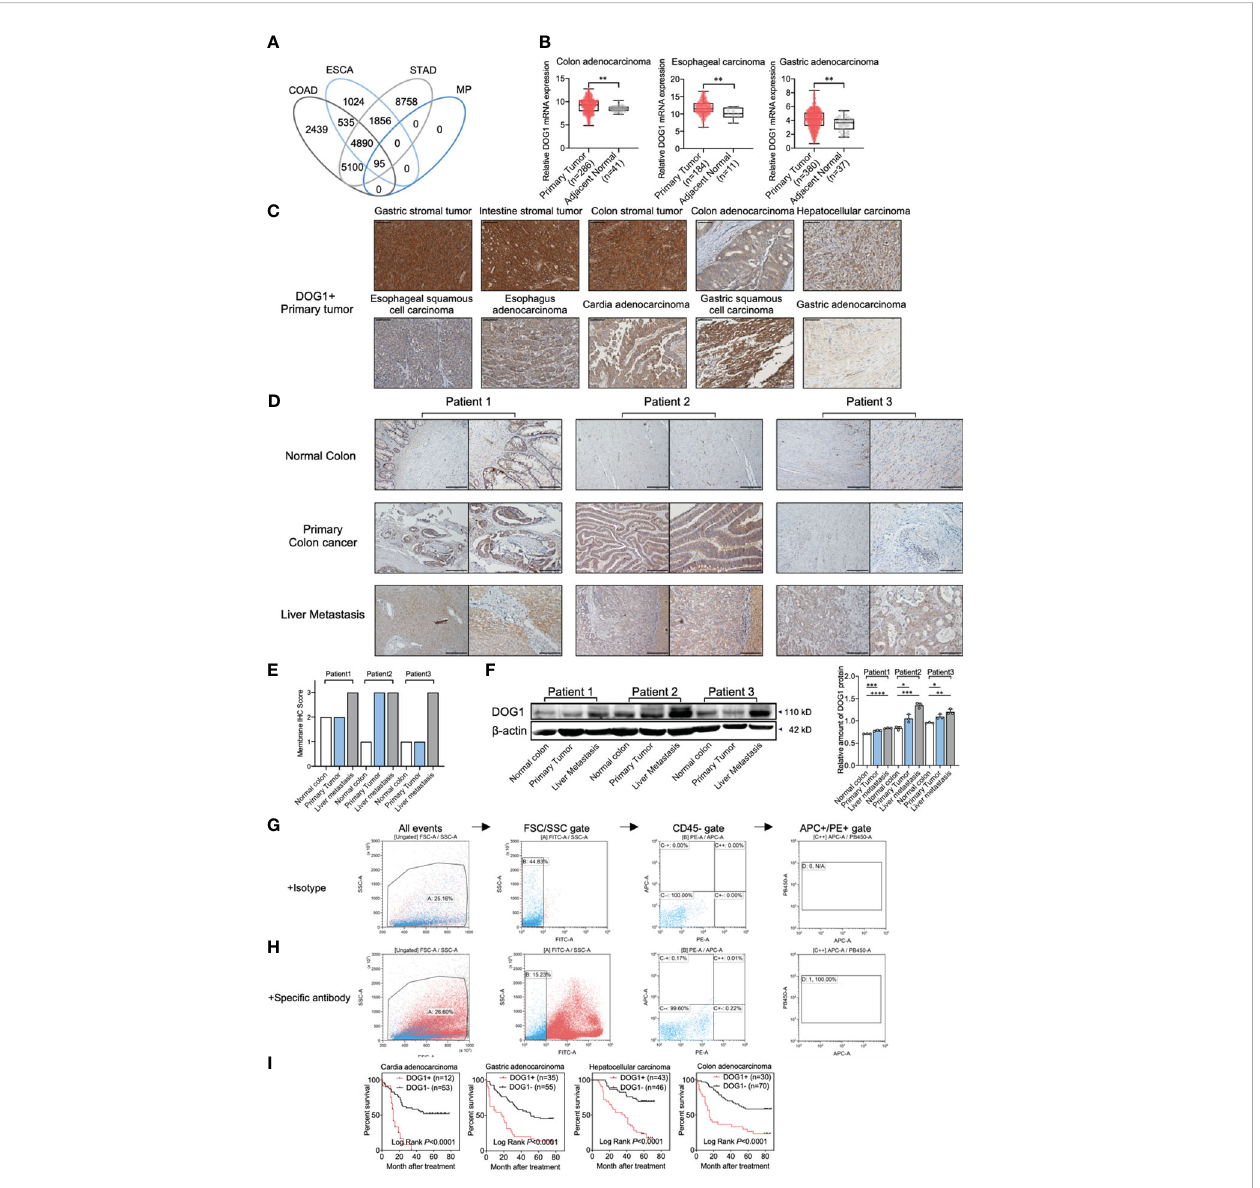
FIGURE 1 DOG1 expression analysis at the gene and protein levels in tumor tissues and CTCs. (A) Venn diagram showing the overlaps between the overexpressed target sets for COAD: Colon adenocarcinoma, ESCA: Esophageal carcinoma, STAD: Stomach adenocarcinoma and MP: Membrane protein; (B) RNA-seq data of multiple gastrointestinal cancers from TCGA analyzed by UCSC Xena (the University of California, Santa Cruz) showed DOG1 RNA expression in primary tumors compared to normal tissues adjacent to the tumor. Axis units are log2 (normalized count+1). Student ’ s t test; (C) Representative immunohistochemical images for DOG1 protein expression in primary tumors. Positive IHC staining for DOG1 is indicated by a brown precipitate. Scale bar, 50 µm; (D) Representative IHC for DOG1in tissue samples from colon cancer patients with liver metastasis. Scar bar is 200 µm (left) and 100 µm (right); (E) DOG1 IHC scores of tissue samples from colon cancer patients with liver metastasis in (D – F) Immunoblot of DOG1 expression in tissue samples from colon cancer patients with liver metastasis by western blot. Quantitative analysis of DOG1 protein expression in tissue samples from colon cancer patients with liver metastasis by western blot (n=3). Commercial anti-DOG1 antibody sp31 used in (A-F) (G) Detection of DOG1+ CTCs from colon cancer patient by fl ow cytometry. Erythrocytes were lysed and cells were stained with an antibody cocktail against CD45, EpCam, Pan Cytokeratin (CK10, 14, 15, 16 and 19) and DOG1 (commercial antibody NBP2-34812AF405). EpCam + CK + CD45 − tumor cells were detected by fl ow cytometry by fi rst gating out the cell debris and cell clumps in the forward/side scatter plot (gate A). Then, the CD45 + (FITC) cells were excluded by gating at the CD45 − cell population (gate B). The thresholds for speci fi c EpCam (APC) and cytokeratin (PE) signals were determined using the sample stained with the isotype control antibodies (gate C). Gates were set to have no positive events above these thresholds in the control sample (gate C++); (H) The same gating strategy was then applied for detecting EpCam + CK + CD45 − cells in the sample stained with the speci fi c antibodies. DOG1 + (PB450) cells were sellected in gate (D) In this plasma sample of colon cancer patient with liver metastasis, 100% (1/1) DOG1 + cells were selected out in CTCs; (I) Kaplan – Meier survival curves for patients with cardia adenocarcinoma, gastric adenocarcinoma, hepatocellular carcinoma and colon adenocarcinoma with DOG1+/ − staining are shown. Log-rank test. Comparison within groups: *P < 0.05; **P <0.01; ***P <0.001; ****P